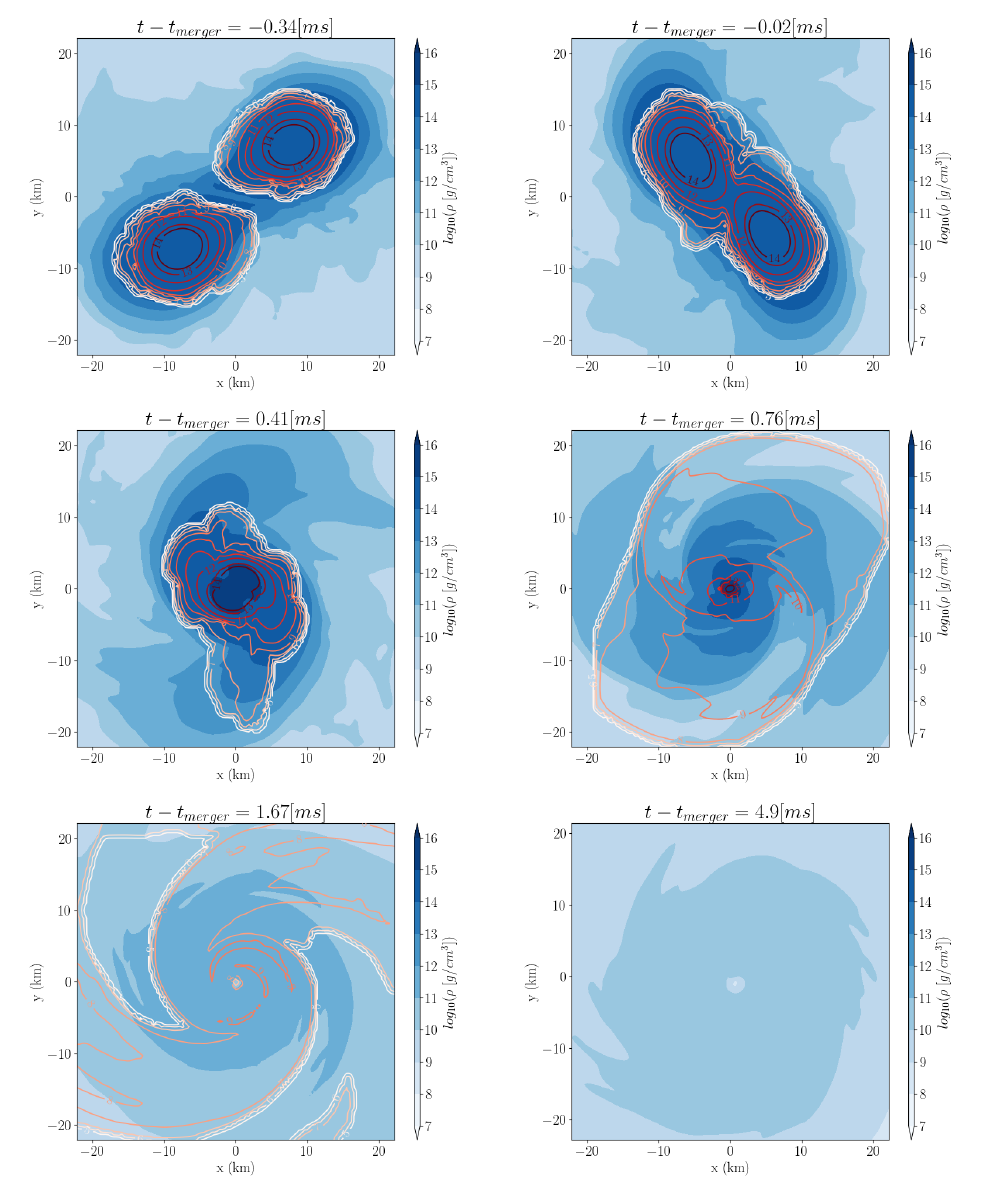
Figure 5. Snapshots on the equatorial plane of the 1.3 M (cid:12) –1.3 M (cid:12) simulation with 5% dark matter. x and y are in isotropic coordinates. The colormap represents the log cgs units. The contours represent the same quantity for mirror dark